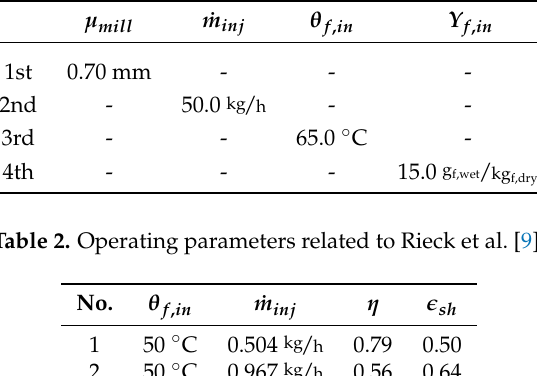
Figure 6. Influence of drying conditions on layer porosity as presented in Rieck et al. [9]: glass particles coated with sodium benzoate according to the operating parameters presented in Table 2. Table 1. Simulation scenarios according to the simulation results presented in Sections 3.1–3.4.